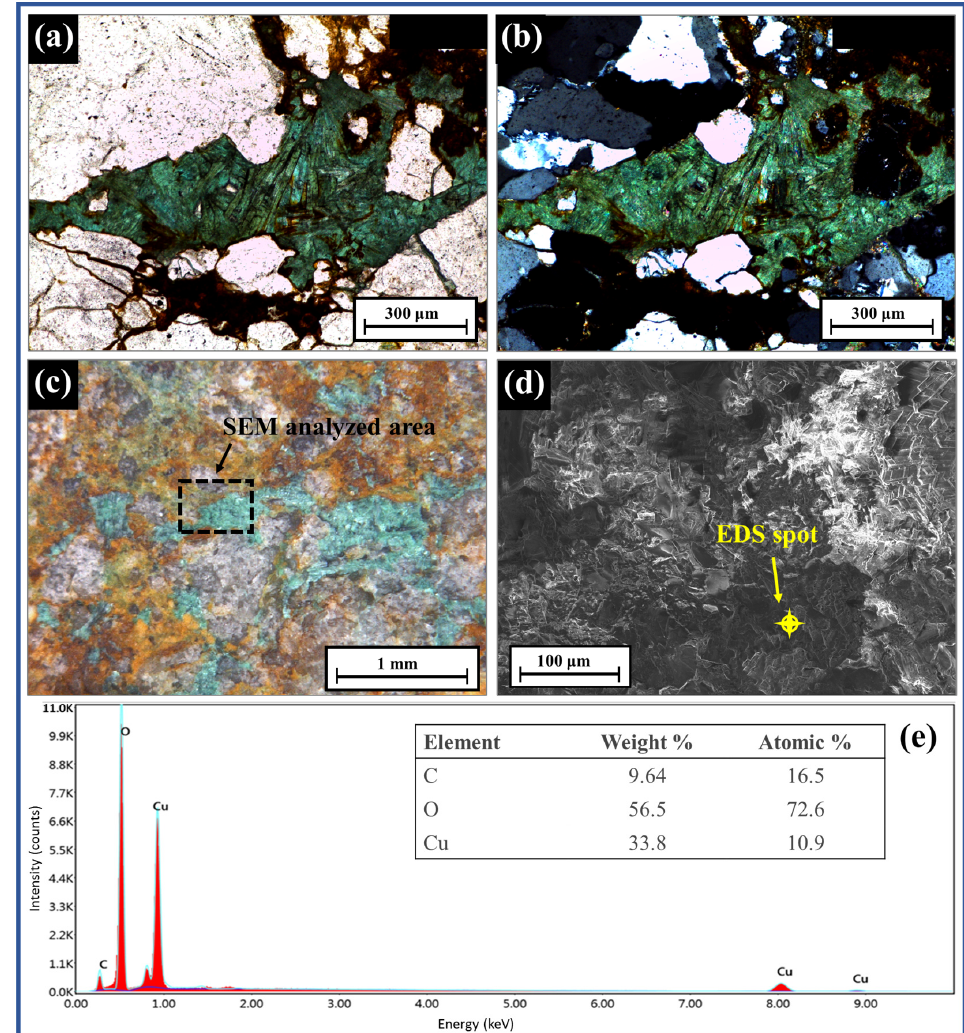
Figure 3. Polarization microscope images with open Nicol ( a ) and crossed Nicol ( b ); reflection microscope image ( c ), SEM image ( d ), and elemental analysis (%) of ore ( e ).